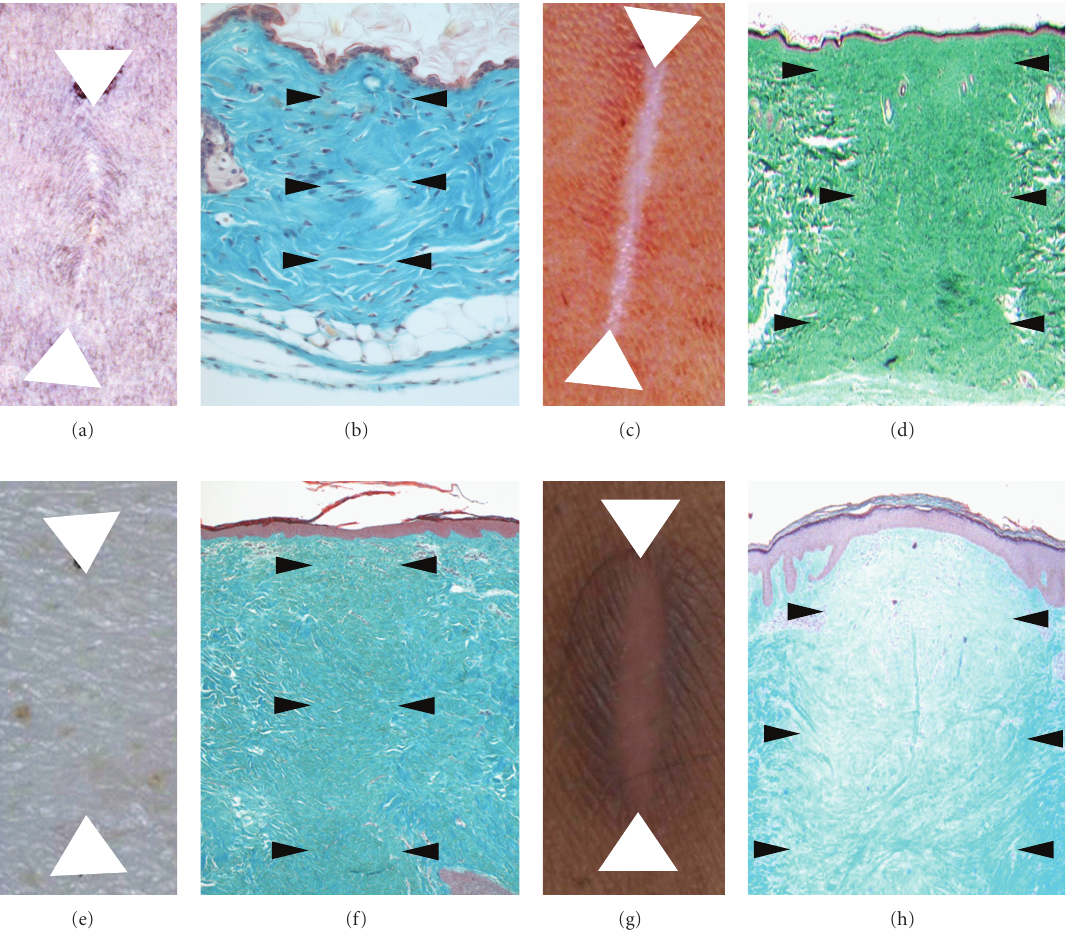
Figure 3: Comparison of Scarring at the Macroscopic and Microscopic Levels between experimental incisional wound models in pre-clinical species and humans. Scarring response in mice 70 days following a 1 cm full thickness incisional wound on the dorsum at the macroscopic ((a) arrowheads indicate ends of original wound) and microscopic ((b) arrowheads indicate scar) levels. Scarring response in rats 84 days following a 1cm full thickness incisional wound on the dorsum at the macroscopic ((c) arrowheads indicate ends of original wound) and microscopic ((d) arrowheads indicate scar) levels. Scarring response in pigs 168 days following a 1cm full thickness incisional wound on the dorsum at the macroscopic ((e) arrowheads indicate ends of original wound) and microscopic ((f) arrowheads indicate scar) levels. Scarring response in humans 365 days following a 1 cm full thickness incisional wound on the inner aspect of the upper arm at the macroscopic ((g) arrowheads indicate ends of original wound) and microscopic ((h) arrowheads indicate scar)